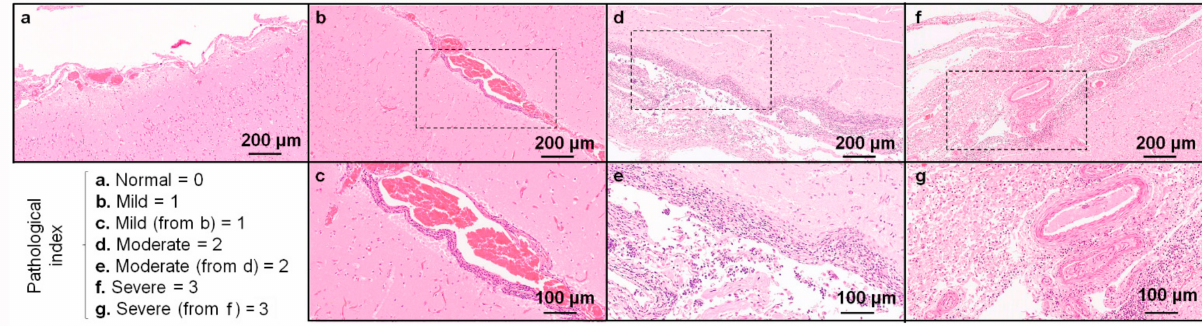
Figure 6. Brain histopathology of dolphins with and without neurobrucellosis. ( a ) Normal brain and meninges section with no signs of neurobrucellosis. ( b ) Brain and meninges sections of a B. ceti infected dolphin showing mild ( b , c ), moderate ( d , e ), and severe ( f , g ) mononuclear inflammatory infiltrate. The panels “c”, “e”, and “g” correspond to magnification indicated in the dotted rectangles in “b”, “d”, and “f,” respectively; panel “a” corresponds to case study S. longirostris CR 22-17; panels “b” and “c” correspond to case study S. coeruleoalba CR 07-19; panels “d” and “e” correspond to case study S. coeruleoalba CR 13-17; panels “f” and “g” correspond to S. coeruleoalba CR 01-18. Hematoxylin and eosin stain. A scale bar is indicated for each